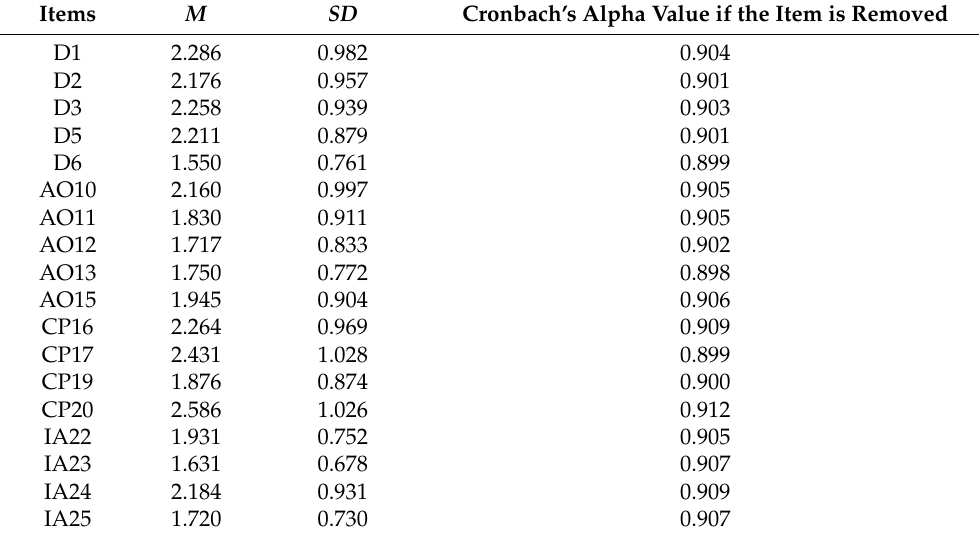
Table 4. Descriptive analysis and internal consistency of items via Cronbach’s alpha